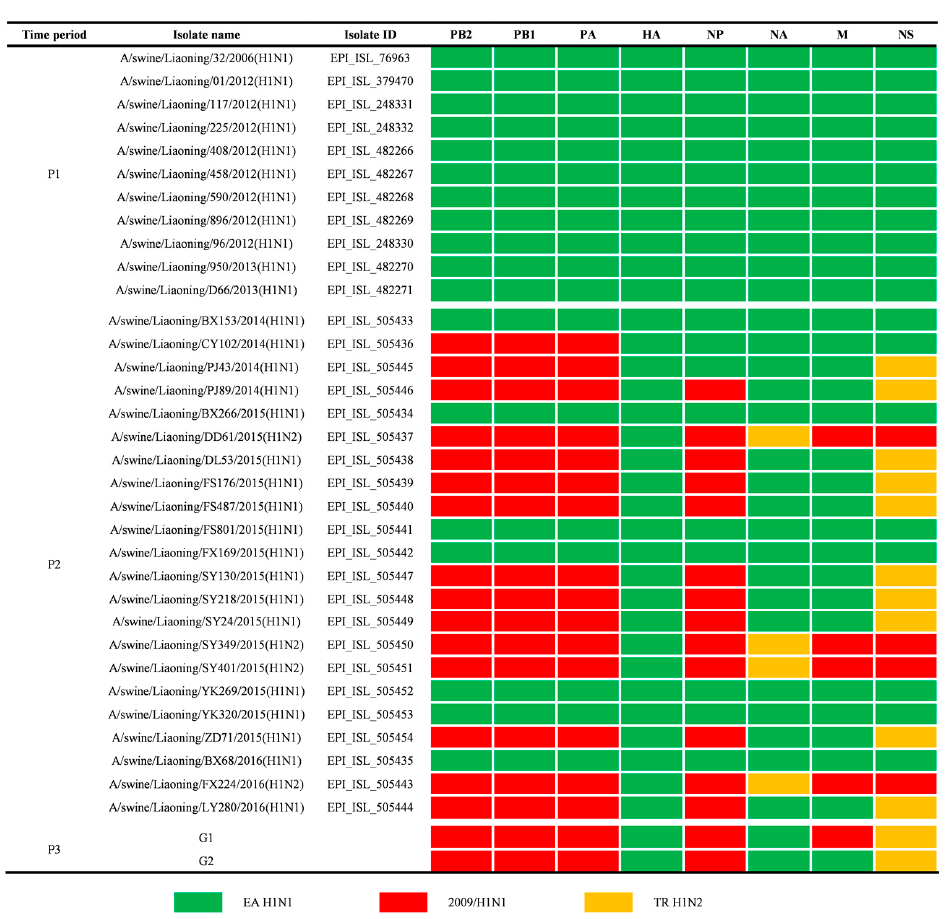
Figure 5. Genotypes of Liaoning EA H1N1 SIVs from 2006 to 2020. The eight gene segments are indicated at the top of each bar. The colors of the bars represent the three SIV lineages. Two genotypes of Liaoning 2020 SIVs were represented by G1 and G2.